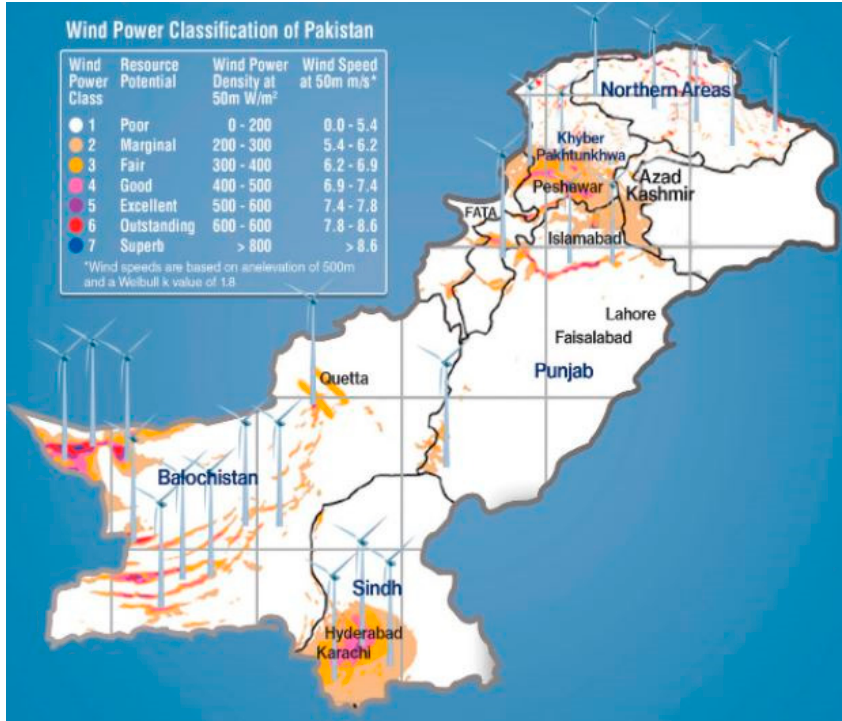
Figure 14. Wind power classification of Pakistan. (1.96”, 1.96).